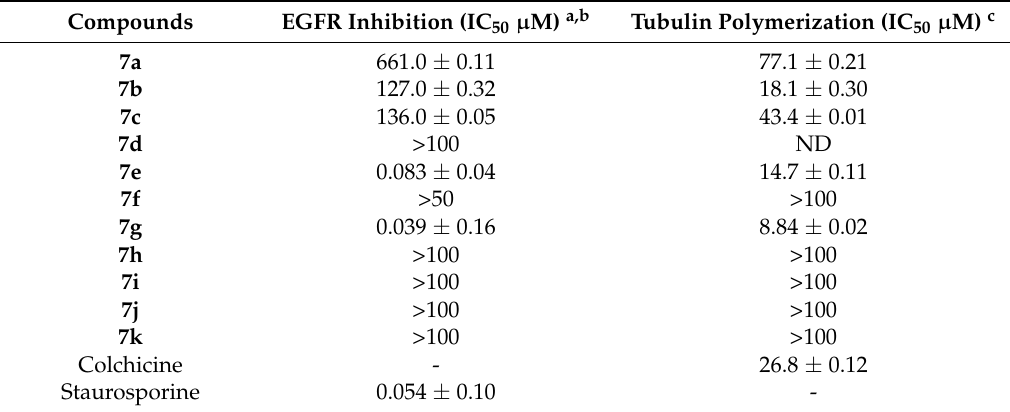
Table 2. Inhibitory data of the selected compounds to both EGFR TK and tubulin polymerization.